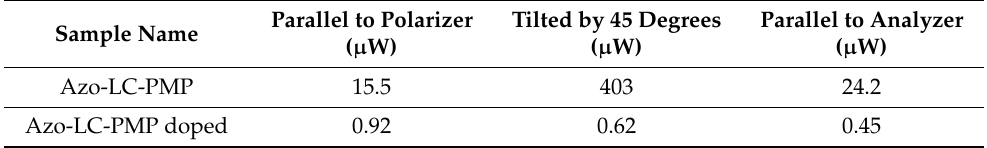
Figure 5. SEM images at different magnification of Azo-LC-PMP-Z6% ( A , B ) and an example of qualitative EDX analysis ( C ) carried out on the sample in correspondence of the aggregate indicated in B. Figure 6 shows topographic and phase contrast AFM images of the ZnO-doped PMP and bare PMP films. Topographic imaging of the composite-based sample clearly displays ZnO nanoparticles dispersed in the polymer matrix, almost uniformly distributed on the whole scanned area (Figure 6A). The root-mean-square roughness (Rq) valuated on the 5 × 5 µm 2 surface gave a result equal to 14.02 nm. As expected, the AFM analysis of the undoped PMP, studied as a comparison, shows a flatter surface characterized by the Rq